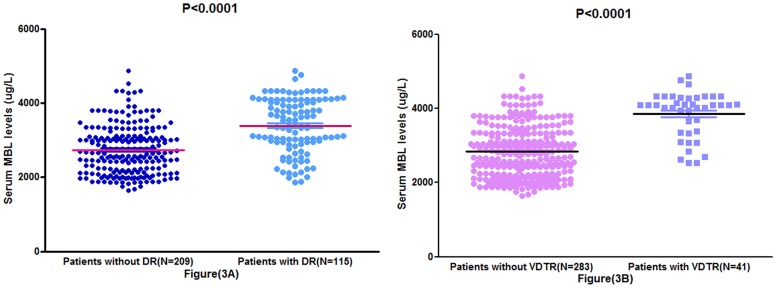
Distribution of serum MBL levels in diabetic patients with different groups.The horizontal lines indicate mean levels. (A) Distribution of serum MBL levels in diabetic patients with DR and without DR; (B) Distribution of serum MBL levels in diabetic patients withvision-threatening diabetic retinopathy (VTDR) and without VTDR. P values refer to Mann-Whitney U tests for differences between groups.